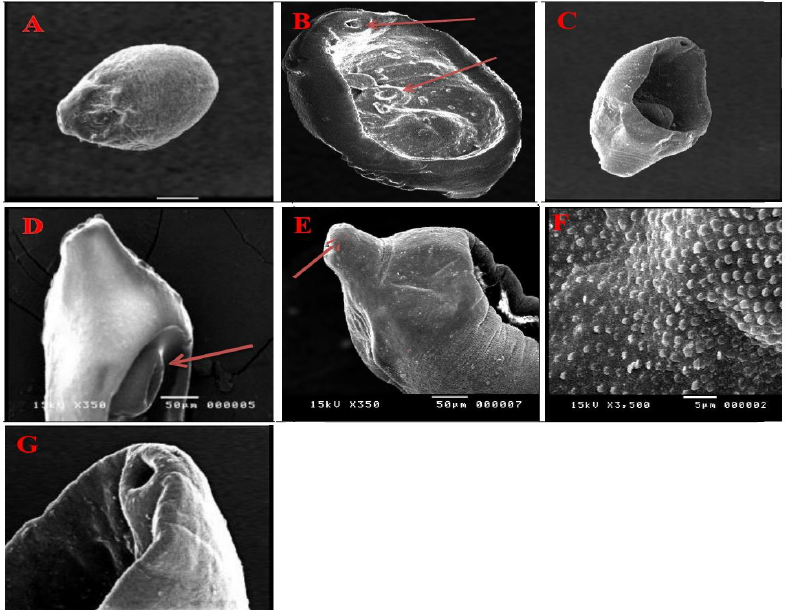
Figure 5. Adult recovered from experimental infection of mice with encysted metacercariae under